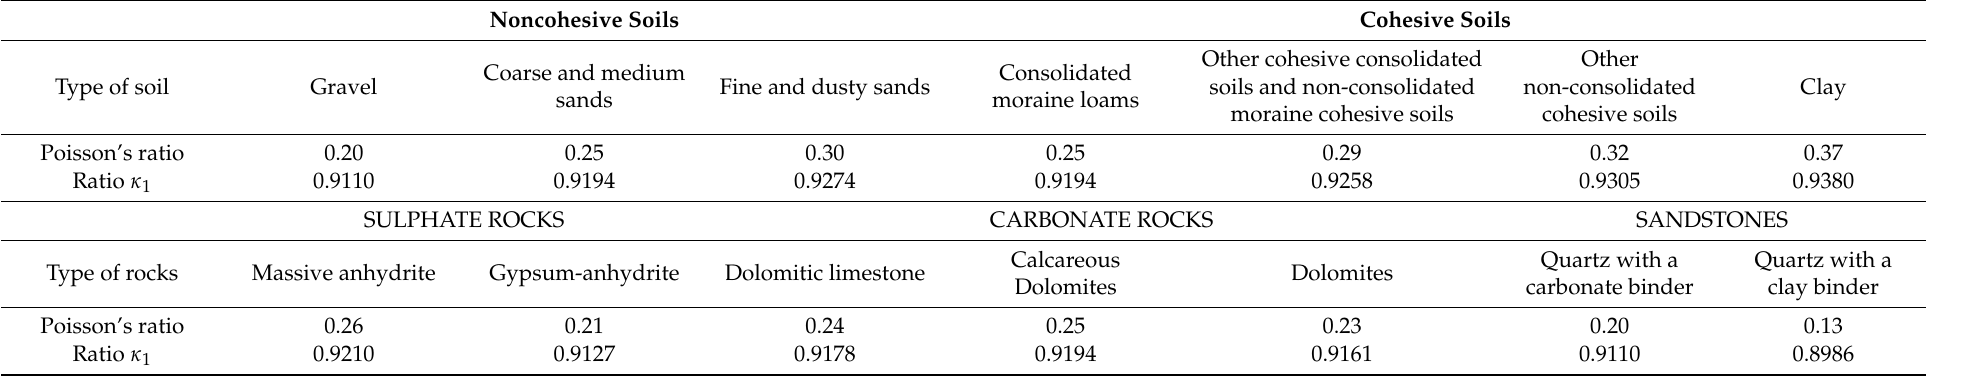
Table 3. Values of the Poisson’s ratio and κ 1 ratio for different kinds of soils (based on